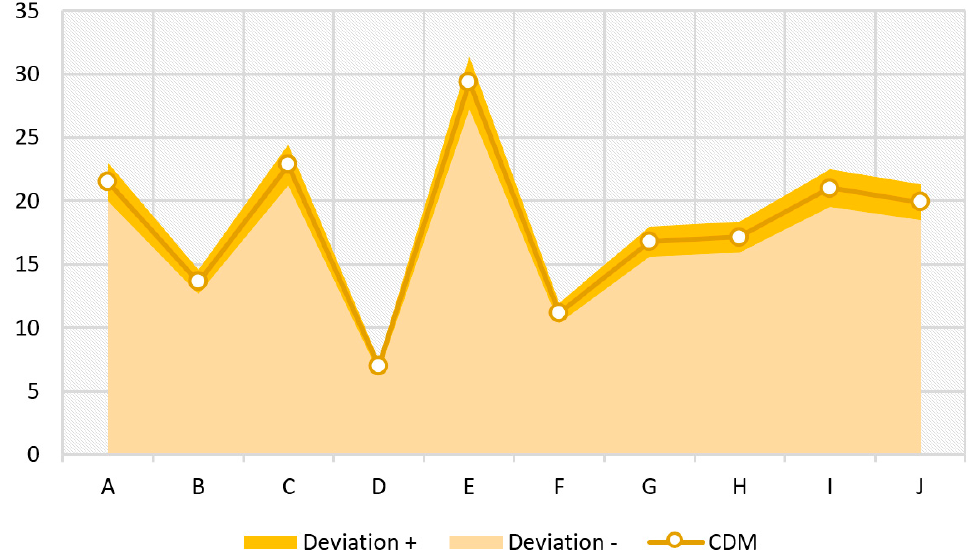
Figure 3. Indicators of the level of financial competitiveness of the companies under study in 2021 as a result of using stochastic analysis. Source: generated by the authors.